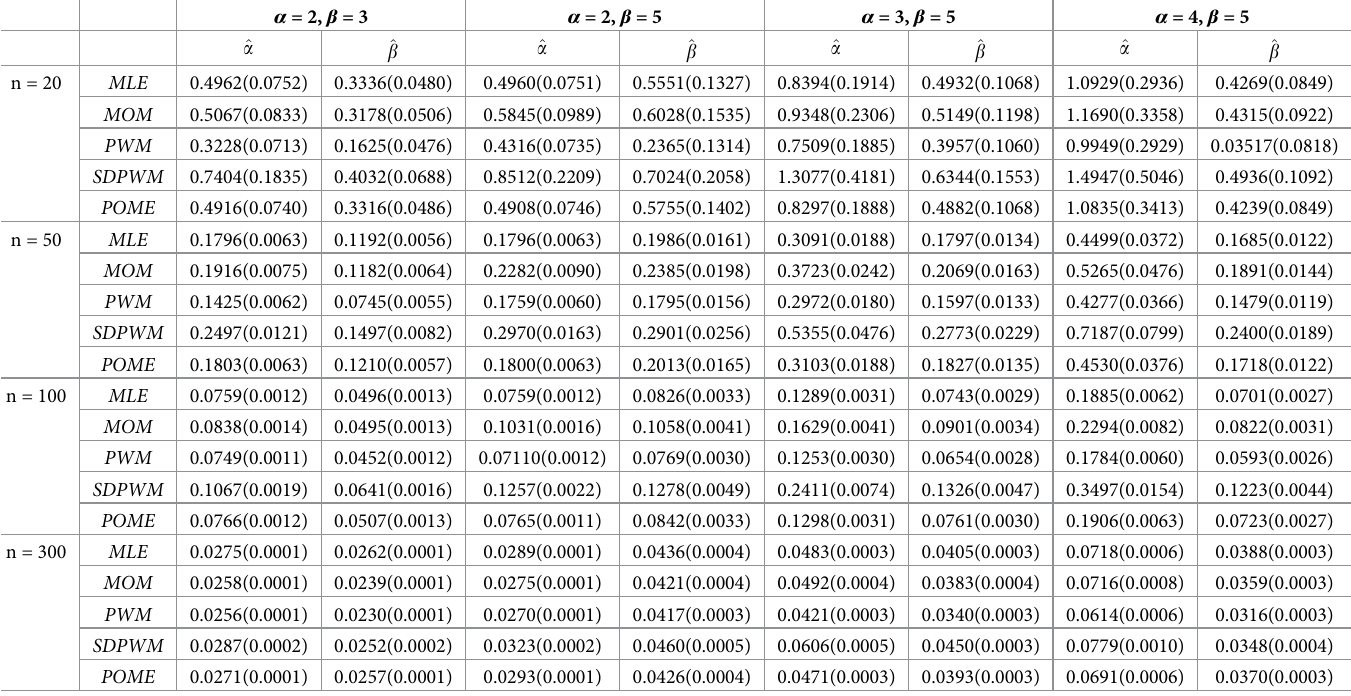
Table 6. Bias and MSE (parentheses) for the estimators of α and β when α < β and for different choices of n .